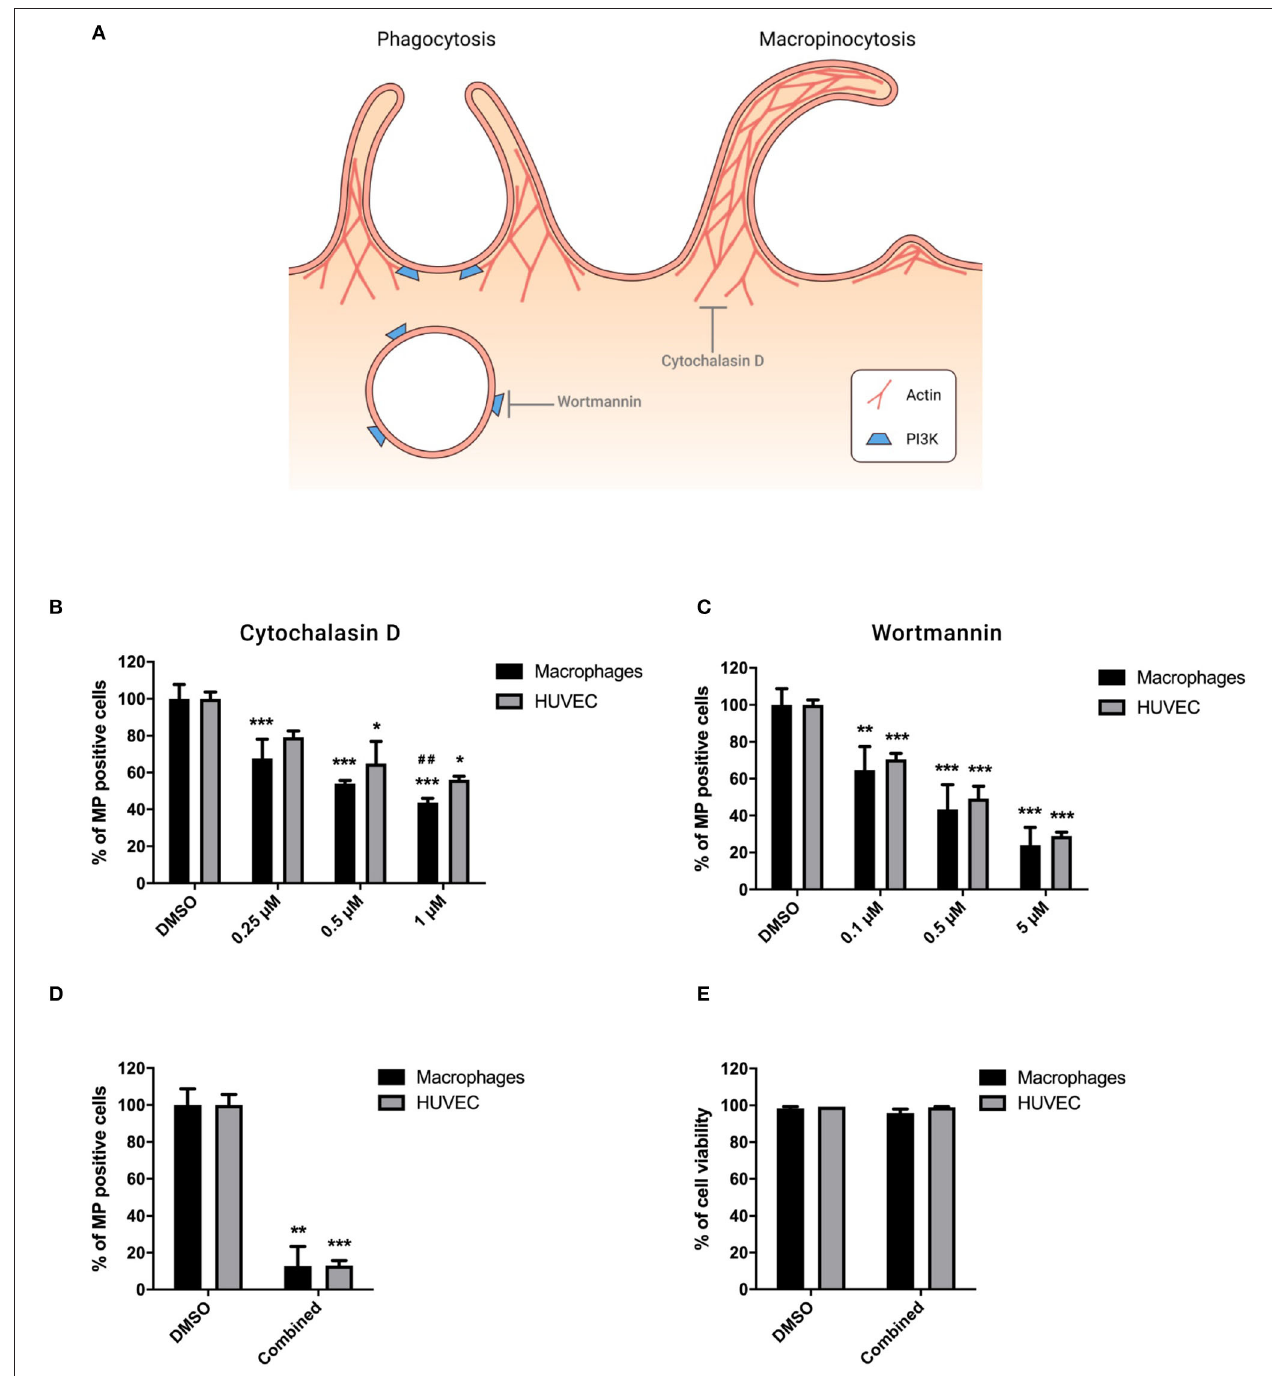
FIGURE 4 | MP internalization involves phagocytosis and macropinocytosis. Cells were preincubated for 30min at 37 ◦ C in complete medium containing Cytochalasin D (0.25, 0.5, and 1 µ M), Wortmannin (0.1, 0.5, and 10 µ M), or combination treatment with inhibitors of endocytosis (10 µ g/ml Heparin and 80 µ M Dynasore) and phagocytosis (5 µ M Wortmannin). PKH-MP were then added to cells (ratio 1:100,000) and analyzed after 6h by flow cytometer. PBS and 0.1% DMSO were used as a control. (A) Phagocytosis and macropinocytosis mechanisms. Percentage of macrophages and HUVEC positive for PKH-MP in the presence of increasing concentrations of Cytochalasin D (B) , Wortmannin (C) , and combined treatment (D) . (E) Percentage of macrophage and HUVEC viability after combined treatment. Data are presented as mean ± SD from 4 to 6 experiments. * P < 0.05 , ** P < 0.01 and *** P < 0.001 vs. vehicle; ## P < 0.001 vs. HUVEC.